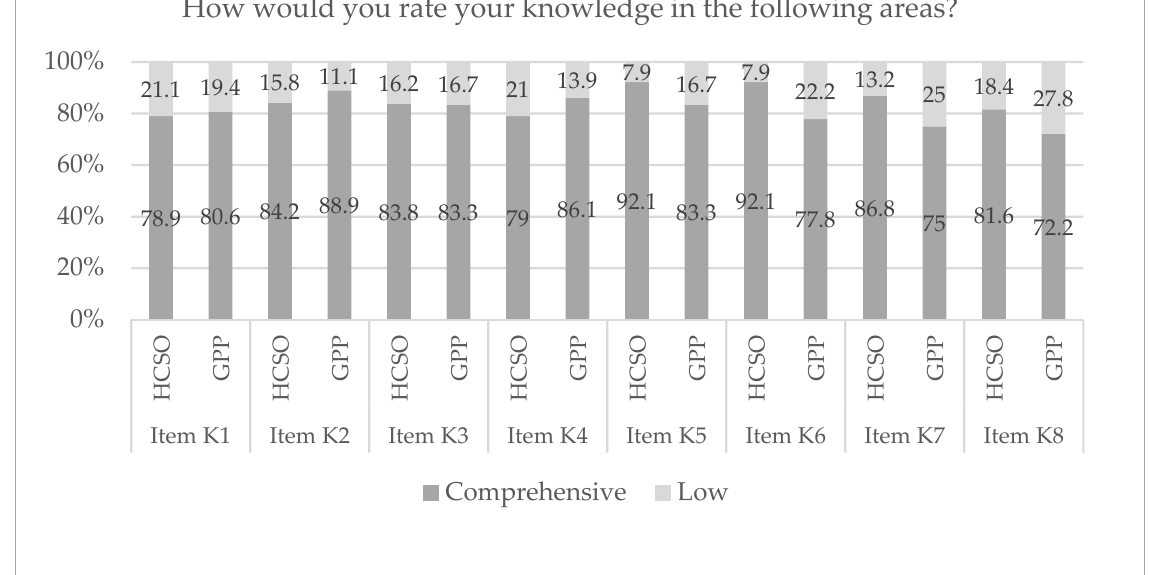
Figure 3. Health professionals’ knowledge regarding health literacy in primary care. Legend: Item K1 = tools to help patients/clients navigate medical offices or hospitals; Item K2 = interview techniques to help patients/clients and their families understand interview information; Item K3 = ways to help patients/clients with language difficulties to articulate themselves; Item K4 = sources of trustworthy and easy-to-understand patient information; Item K5 = approaches to help patients/clients make decisions about their care; Item K6 = ways to help patients/clients make lifestyle changes; Item K7 = services to help patients/clients manage their conditions; Item K8 =